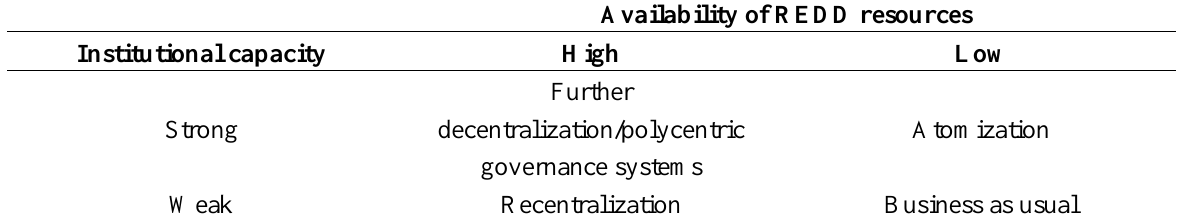
Table 1. Interplay between institutional capacity at subnational level and availability of REDD